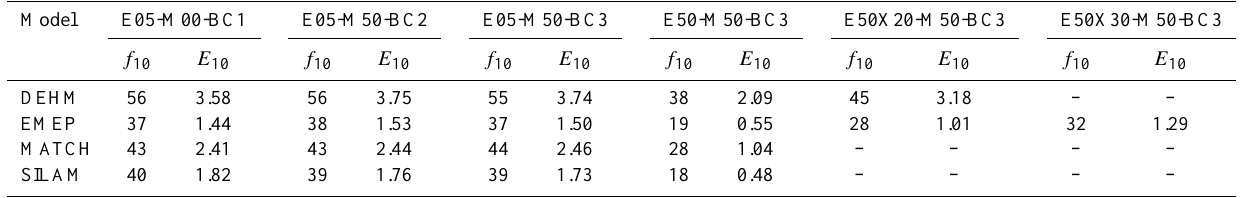
Table 6. Excess Nr deposition over 10kg ( N ) ha − 1 yr − 1 for the four CTMs in the EU28 + region. Model